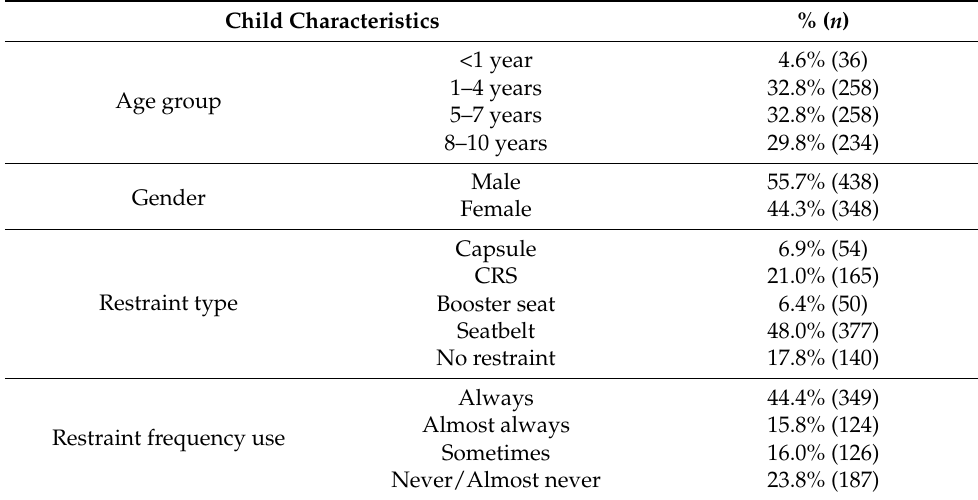
Table 2. Eldest child characteristics and type and frequency of restraint use.